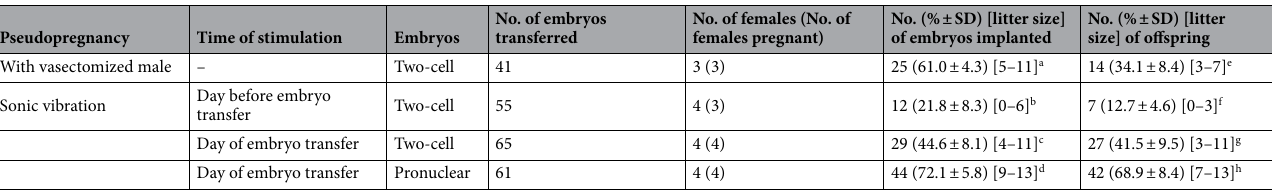
Table 1. Development of embryos transferred to females with pseudopregnancy induced by sonic vibration. Significant differences at P < 0.05: a versus b, b versus c and d, c versus d, e versus f, f versus g and h, g versus h.